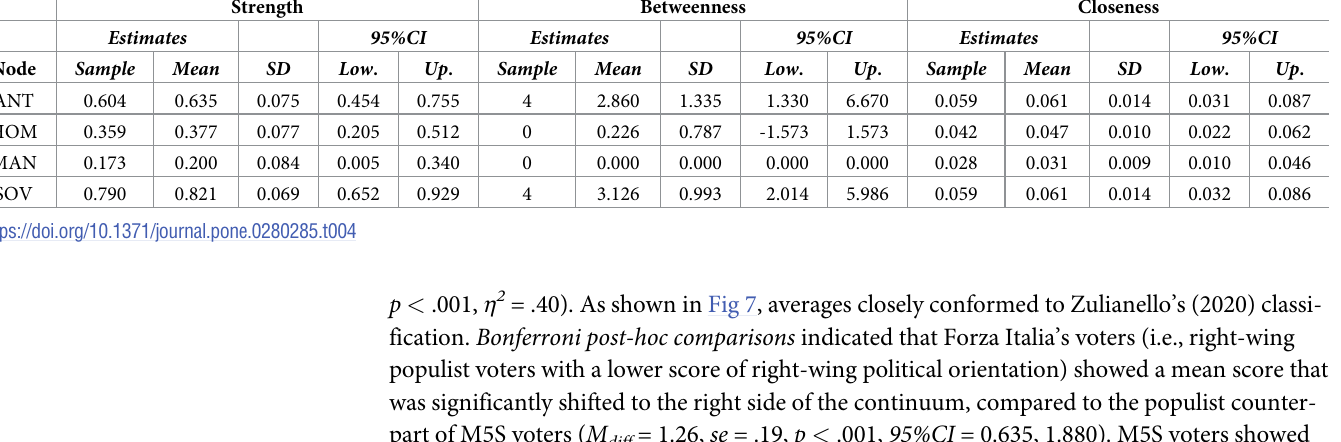
Table 4. Sample and bootstrap mean of centrality indices of the populist ideology dimensions network. Strength Betweenness Closeness Estimates 95%CI Estimates 95%CI Estimates 95%CI Node Sample Up . Sample